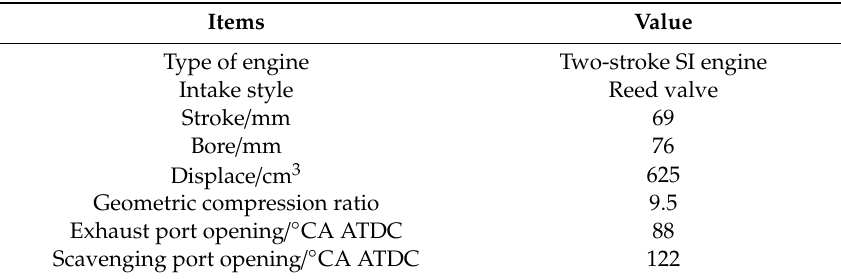
Table 2. Test engine specifications.